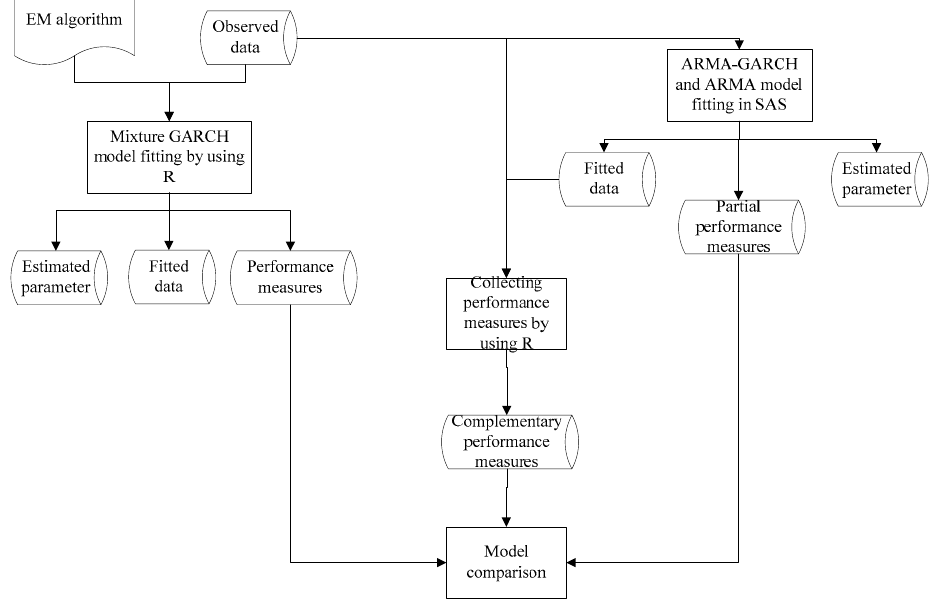
Figure 1. Procedure of fitting finite mixture GARCH model and comparison with ARMA and ARMA-GARCH models.